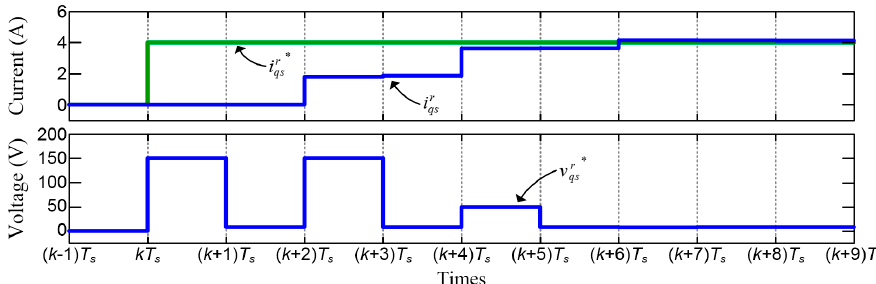
Figure 9. The simulated q -axis current, current command, and voltage command when the current command steps from 0 A to 4 A.